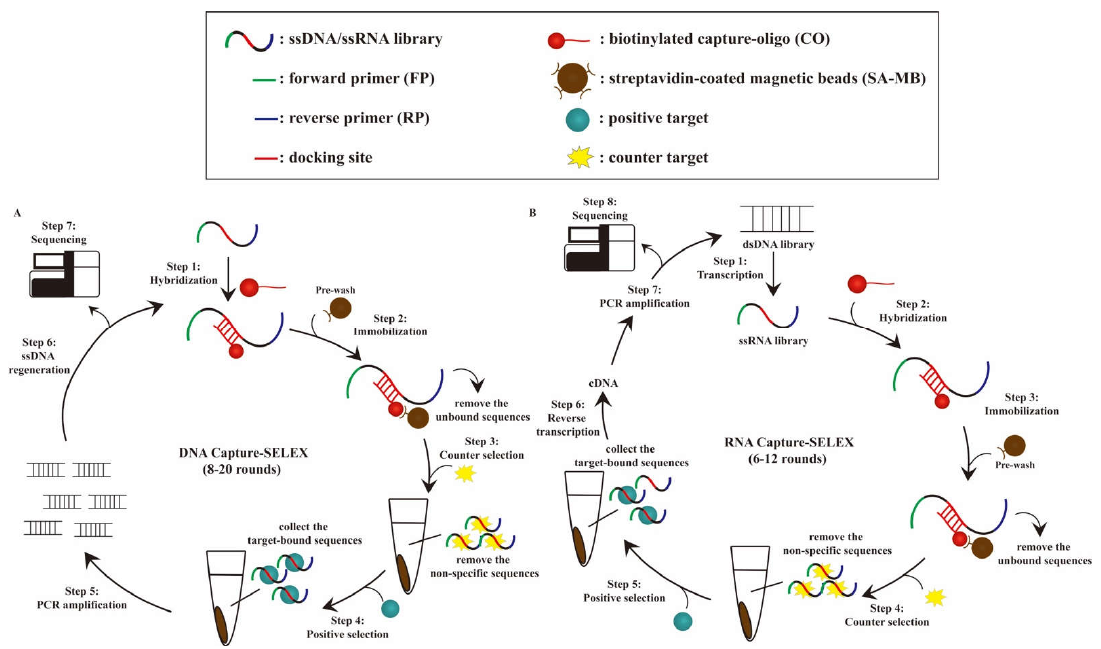
Figure 1. The experimental flowchart of DNA Capture-SELEX and RNA Capture-SELEX. ( A ) DNA Capture-SELEX. Each DNA Capture-SELEX selection round consists of 7 main steps: (1) The designed ssDNA library template is hybridized with biotinylated capture-oligonucleotide. (2) The hybridized product is immobilized on the washed streptavidin-coated magnetic beads. (3–4) Target-bound sequence elution: counter selection is followed by positive selection. (5) PCR amplification was performed on the eluted ssDNA to obtain the amplified dsDNA pool, (6) and regenerate ssDNA for the next DNA Capture-SELEX round (either gel purification or magnetic bead-based method). (7) After DNA Capture-SELEX, aptamer sequences were identified through sequencing. ( B ) RNA Capture-SELEX. The principles and procedures are similar to ( A ), except that RNA Capture-SELEX consists of additional transcription (step 1) to convert DNA to RNA and reverse transcription (step 6) to convert RNA to DNA steps.